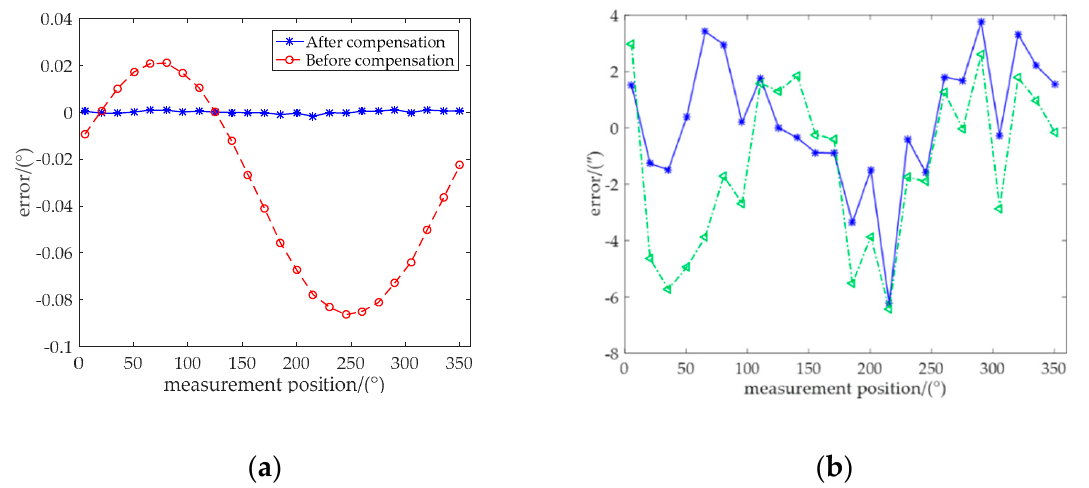
Figure 8. ( a ) Errors using one reading head before and after compensation. ( b ) Errors of algorithm and hardware compensation using one and double reading heads, respectively.